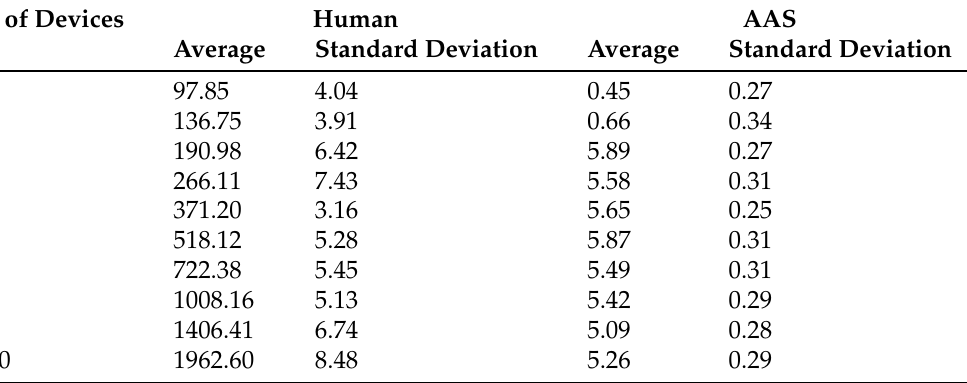
Table 1. Mean and standard deviation of the time to perform PTP reconfiguration physically (by human intervention) and automatically (using AAS) in our target company. Five samples were collected for every